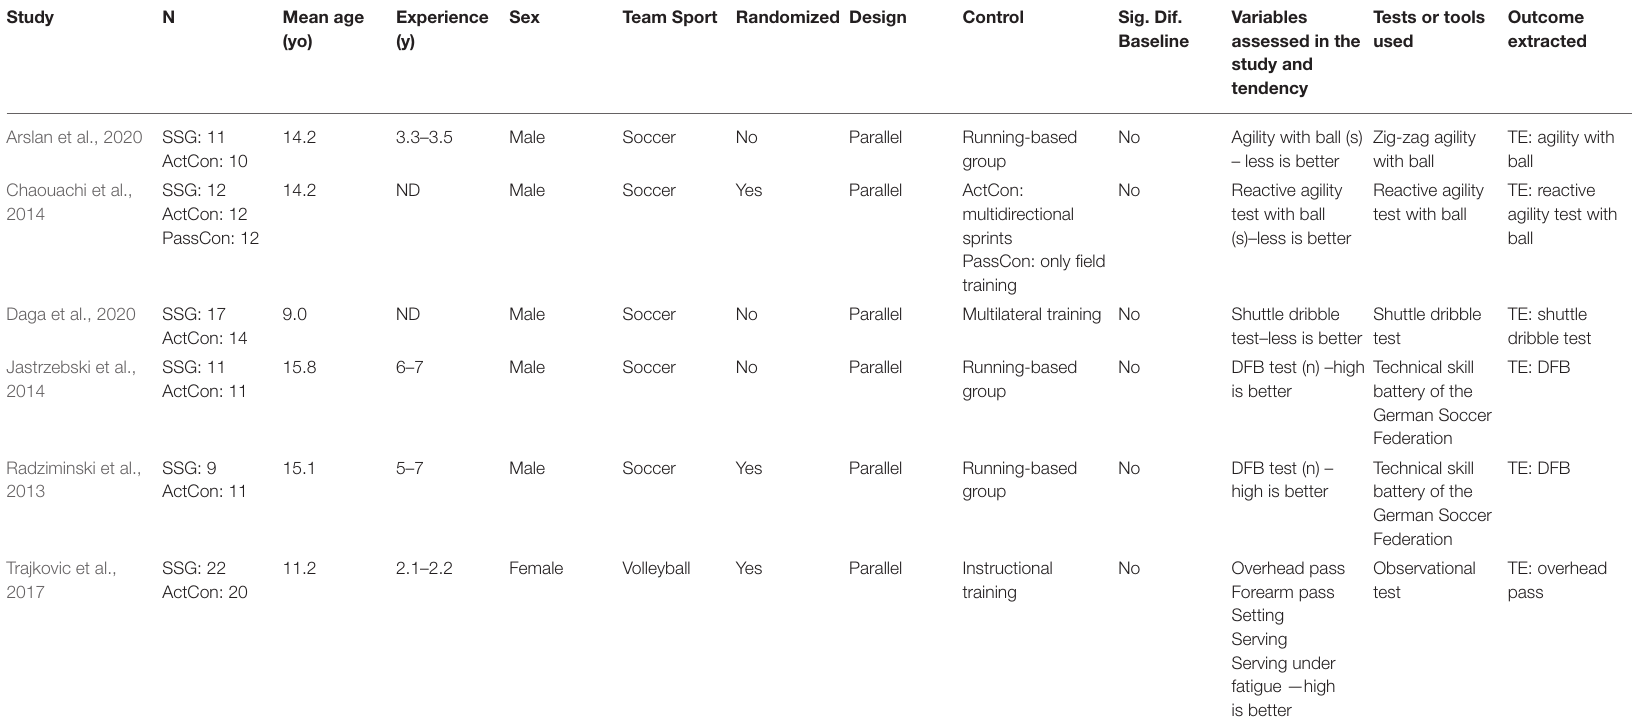
TABLE 4 | Characteristics of the included studies and outcomes extracted. Study N Mean age